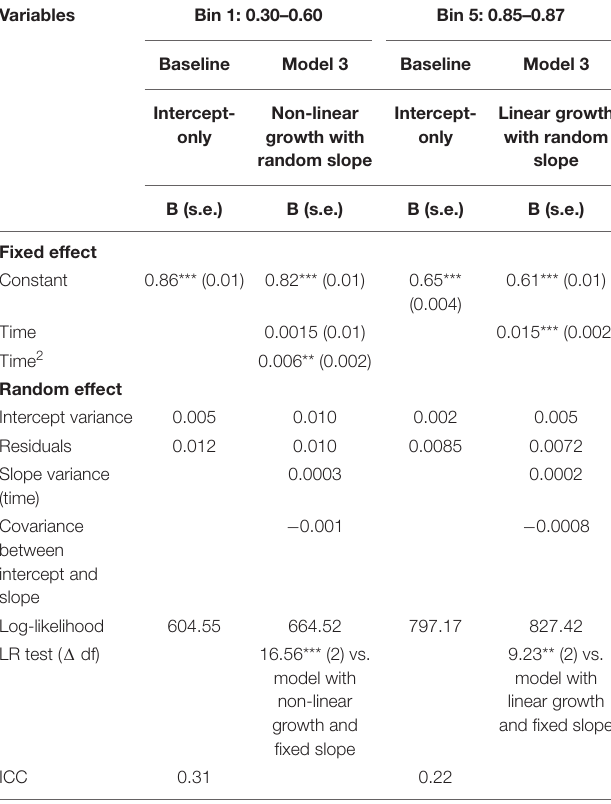
TABLE 9 | Cohort 2: results of ME growth models for changes in ANS accuracy for the easiest (0.30–0.60) and hardest (0.85–0.87) ratio bins from grade 5 to grade 9.